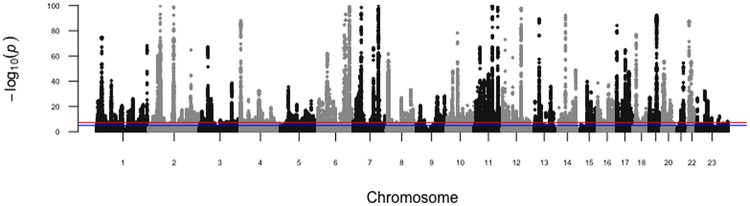
Manhattan plot for genome-wide association analysis of eBMD.The -log10 p-values for association with eBMD of SNPs from the LMM analysis are plotted by genomic position with chromosome number listed across the bottom. The y-axis shows the -log10 p-value for association with eBMD. The blue line represents suggestive genome-wide significance (p<5x10-5) and the red line represents genome-wide significance (p<6.6x10-9).